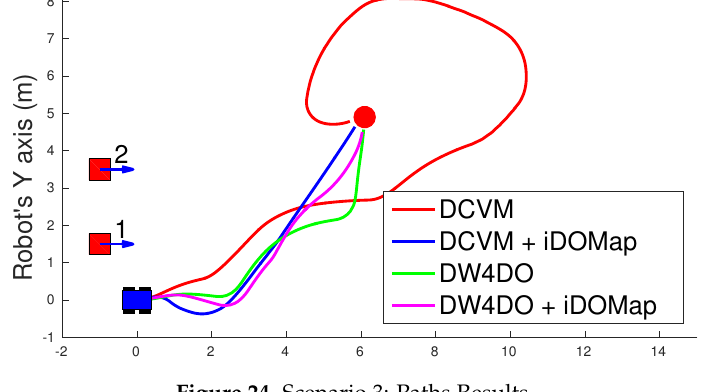
Figure 24. Scenario 3: Paths Results.